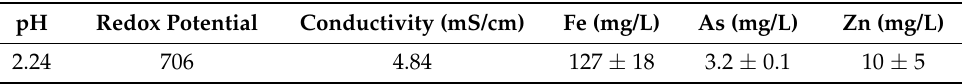
Table 1. Characterization of the Caracarani River waters used in the adsorption